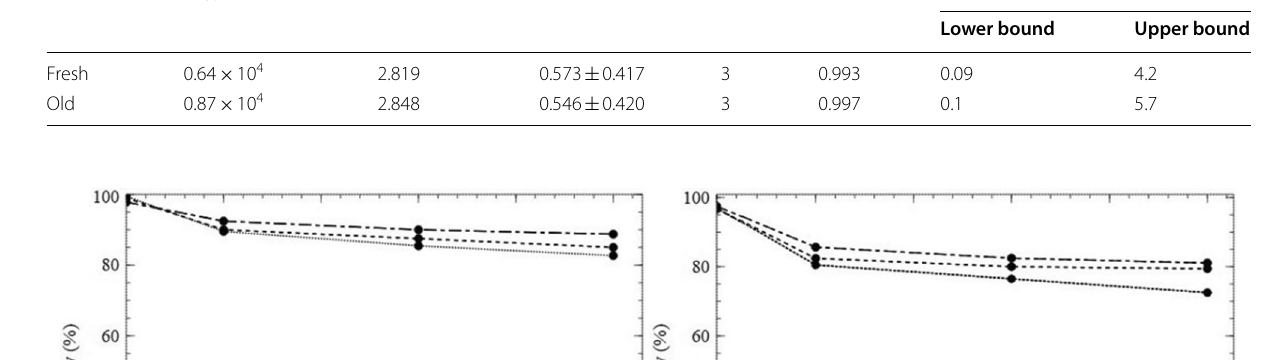
Table 2 LC values of two formulations on Hyphantria cunea larvae 50 Isolate